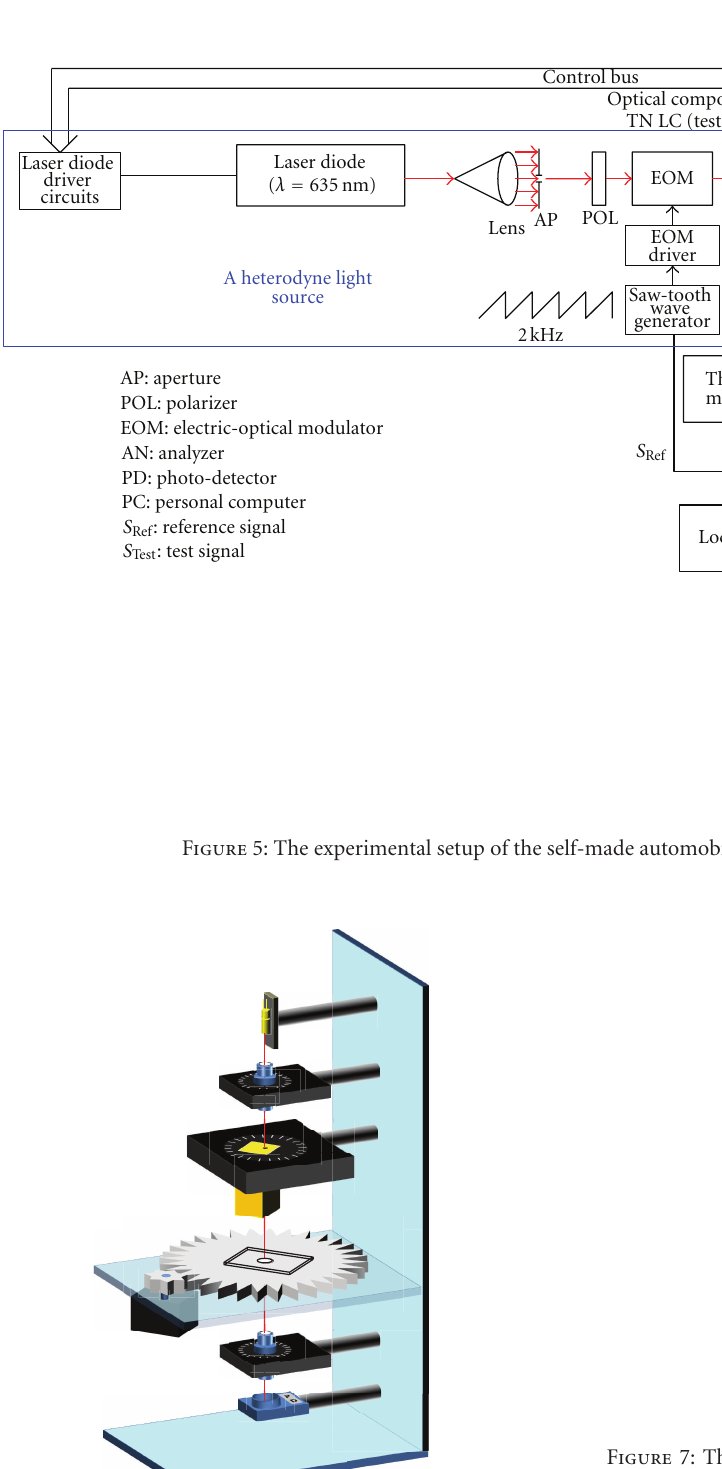
Figure 7: The photo picture of the self-made automobile hetero- dyne interferometer (A: laser diode driving circuits; B: laser diode with the wavelength of 635nm; C: EOM, electrooptical modulator; D: the tested LC; E: five-axis machine arm; F: the unfinished region; G: the finished